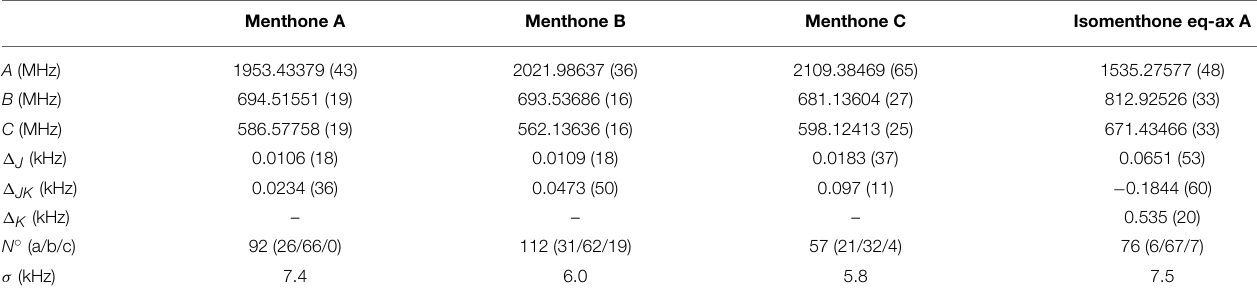
TABLE 3 | Experimentally determined rotational constants and quartic distortion constants of menthone and isomenthone. Menthone A Menthone B Menthone C Isomenthone eq-ax